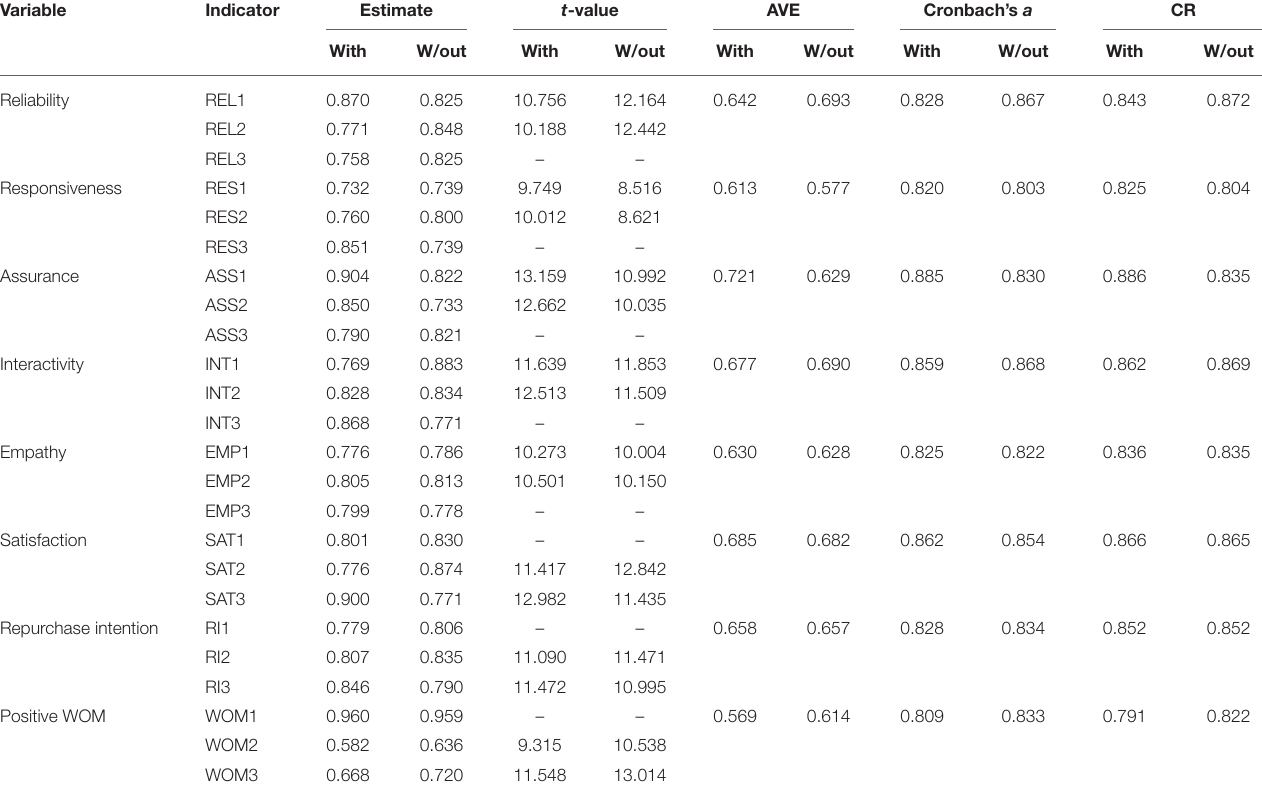
TABLE 3 | Reliability and validity tests: with and without emotion words.